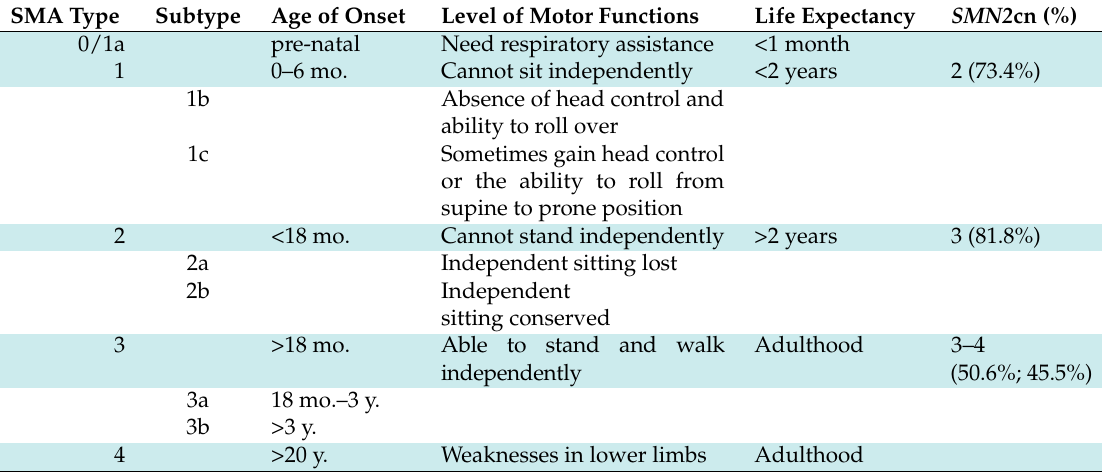
Table 1. Current classification of spinal muscular atrophy (SMA) patients in 5 types. The subtypes, age of onset (mo.: months; y.: years), level of motor functions, life expectancy, and frequency of